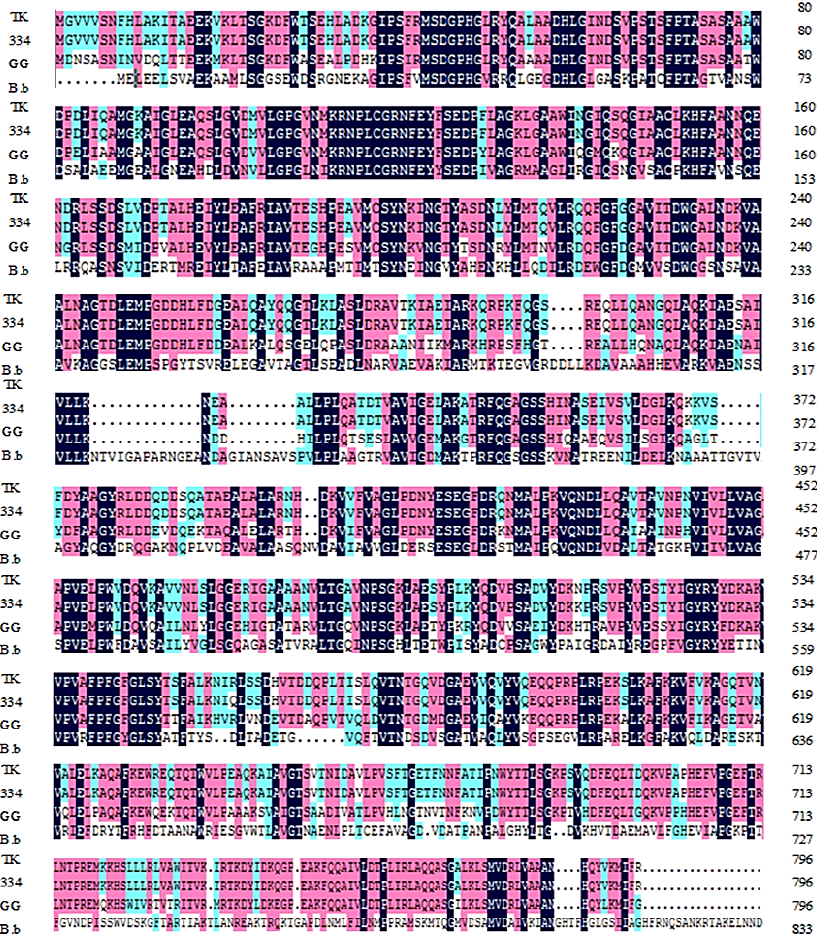
Figure 3. Comparison of β -glucosidase amino acid sequences from L. paracasei TK1501 (TK) with L. casei ATCC334 (334), L. rhamnosus GG (GG), and Bifidobacterium B.b (B.b). The navy-blue means consistent residues in all four enzymes, purple means consistent residues in three enzymes, and light blue means consistent residues in two enzymes.